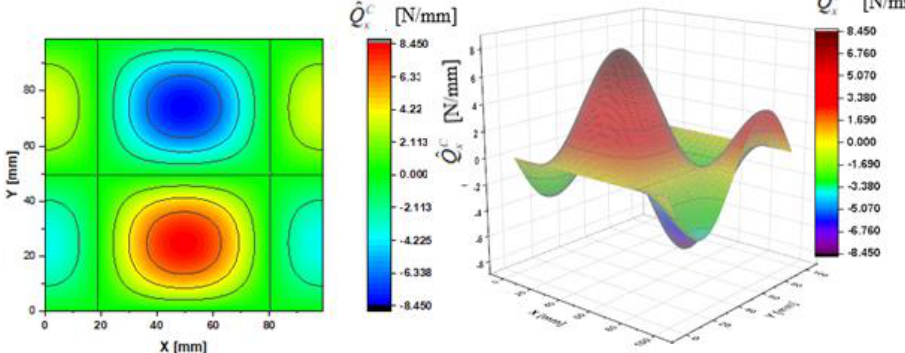
Figure 2. Contour-plane chart of ˆ Q C x for Case A.